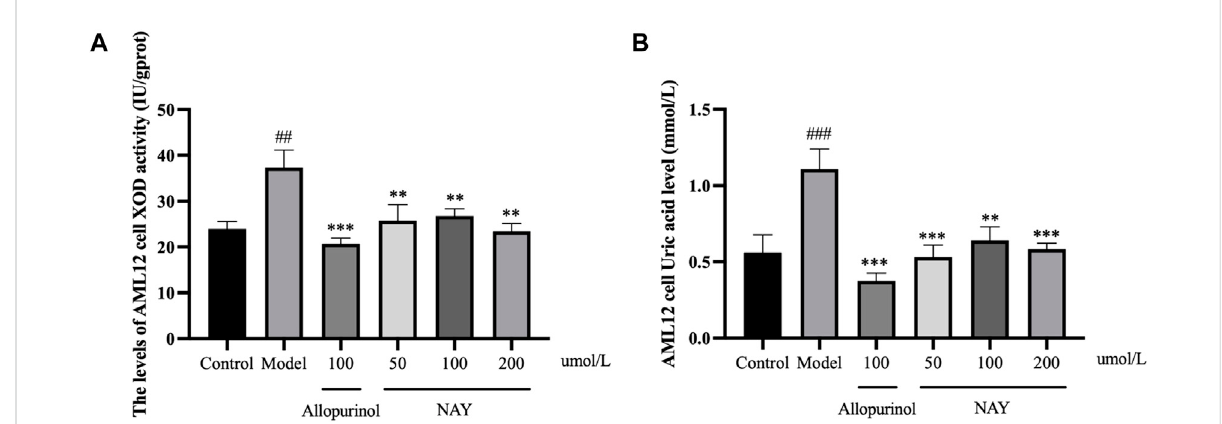
FIGURE 9 Effects of NAY on the levels of XOD activity (A) and culture medium UA (B) in AML12 cells. (Data were expressed as mean ± S.E.M.; n = 5. Compared with the control group, # p < 0.05, ## p < 0.01, and ### p < 0.001. Compared with themodel group, * p < 0.05, ** p < 0.01,and *** p < 0.001).